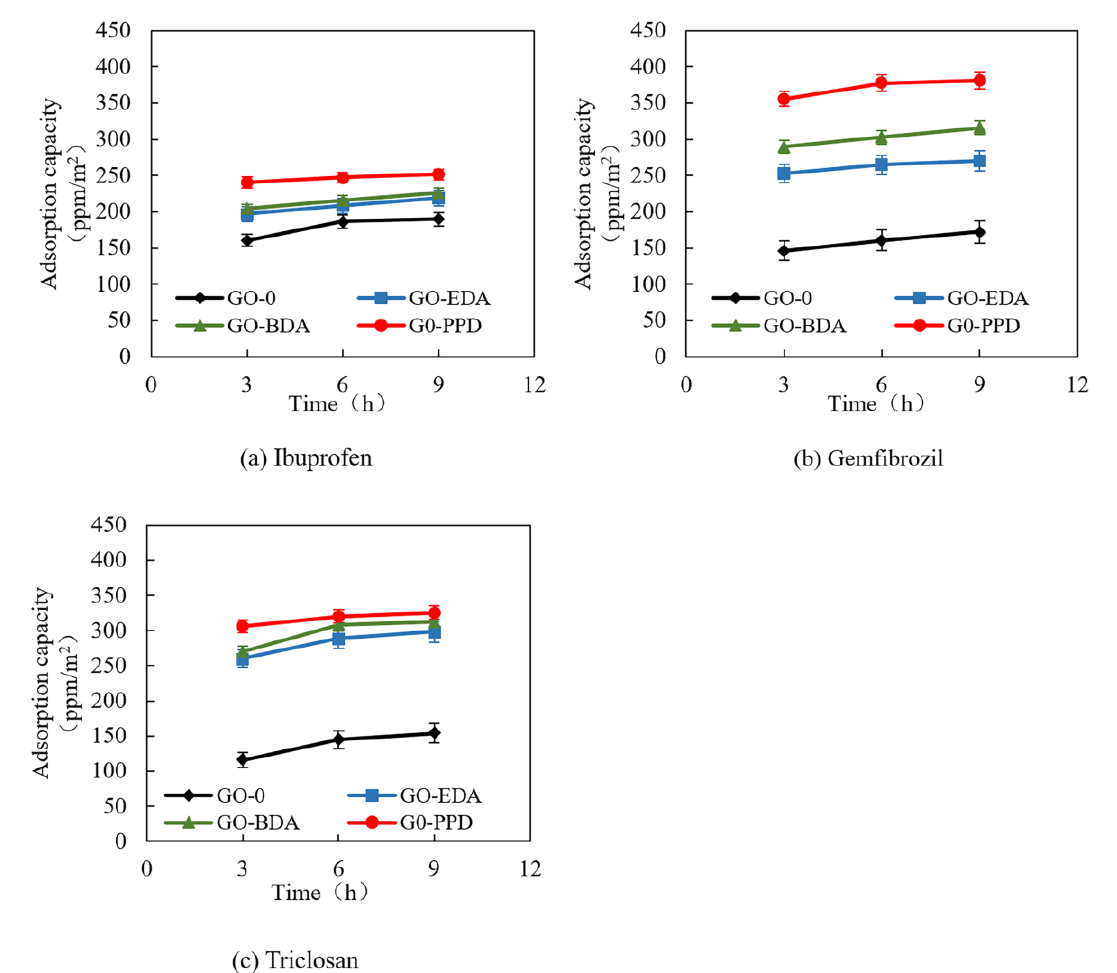
Figure 6. The adsorption capacity of the pharmaceuticals and personal care products (PPCPs) ( a ) ibuprofen, ( b ) gemfibrozil, and ( c ) triclosan onto the cross-linked GO membrane in the absence of pressure.